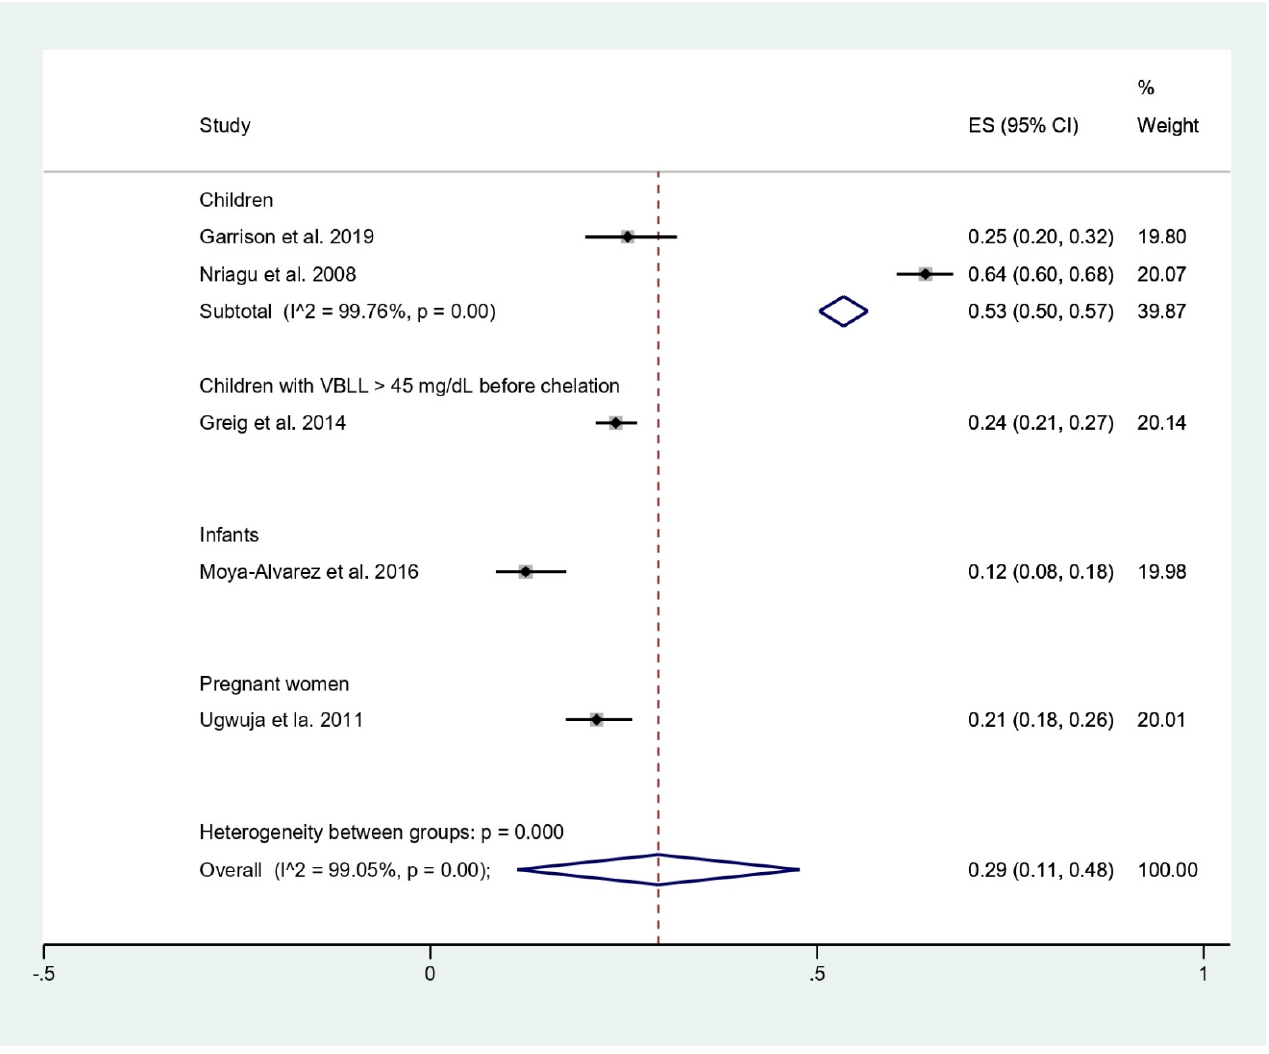
Figure 3. Pooled prevalence of malaria by types of participants. ES, effect size (prevalence of malaria); CI, confidence interval; black diamond symbol, point estimate; solid line in the middle of the graph at 0, zero effect size .